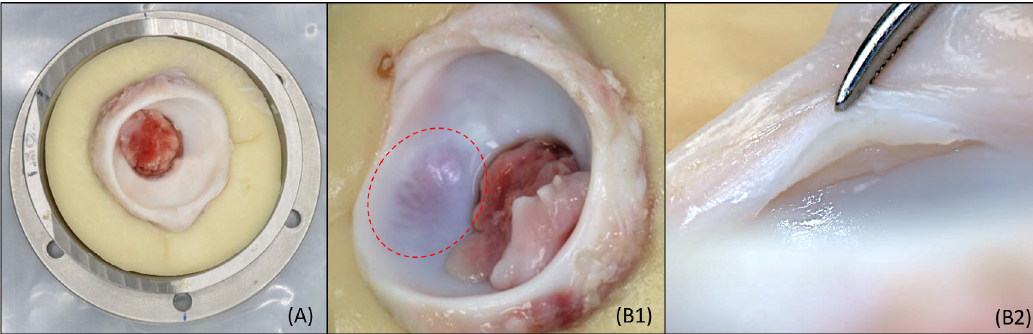
Fig 9. Sample photogrammetry of porcine acetabulum. (A) Wide lens photographs show the positioning of the sample and its overall condition prior to simulation. (B) Macro lens photograph shows the condition of the tissue in more detail. Images show examples of damage present after an OL+ simulation for 14,400 cycles. (B1) Cartilage blushing. (B2) Labral tear and separation of the chondrolabral